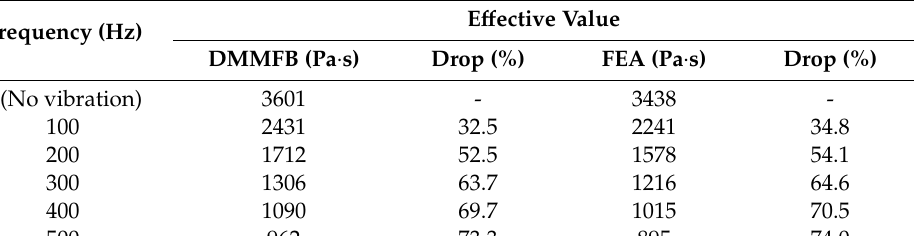
Table 10. E ff ective value of the apparent viscosity without and with 0.3 g vibration applied at di ff erent frequencies.